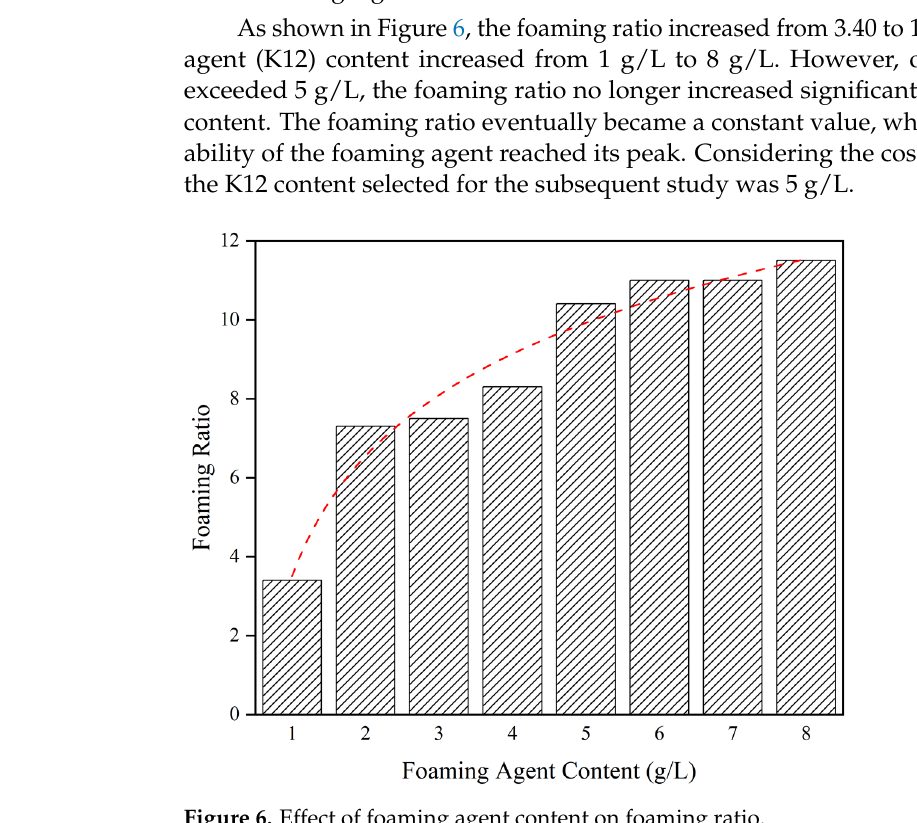
Figure 6. Effect of foaming agent content on foaming ratio.